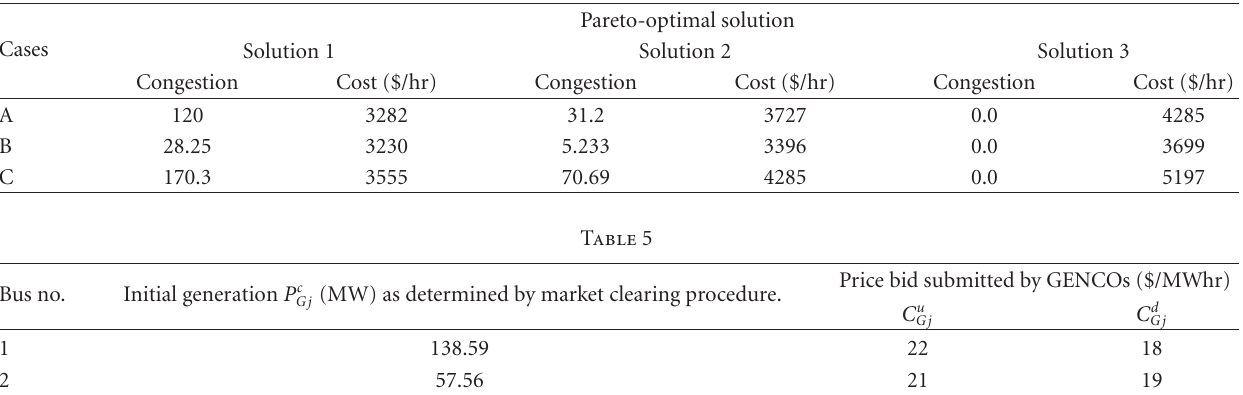
Table 4: Pareto optimal solution for all three cases.